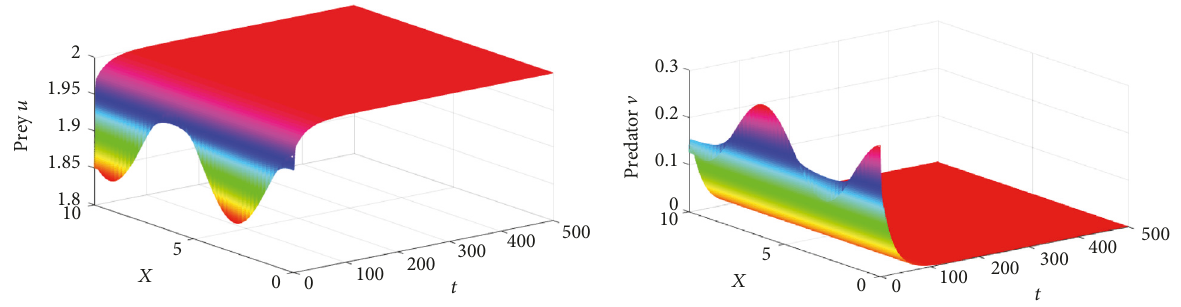
Figure 1: The steady state 𝐸 1 is globally asymptotically stable.